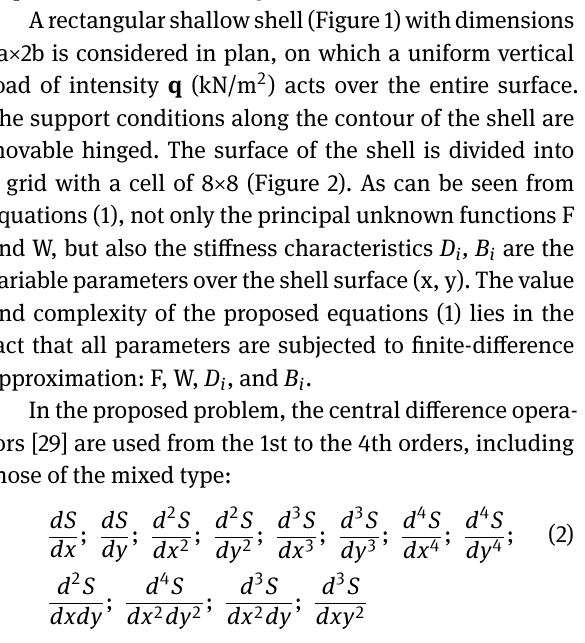
A rectangular shallow shell (Figure 1) with dimensions 2a×2b is considered in plan, on which a uniform vertical load of intensity q (kN/m 2 ) acts over the entire